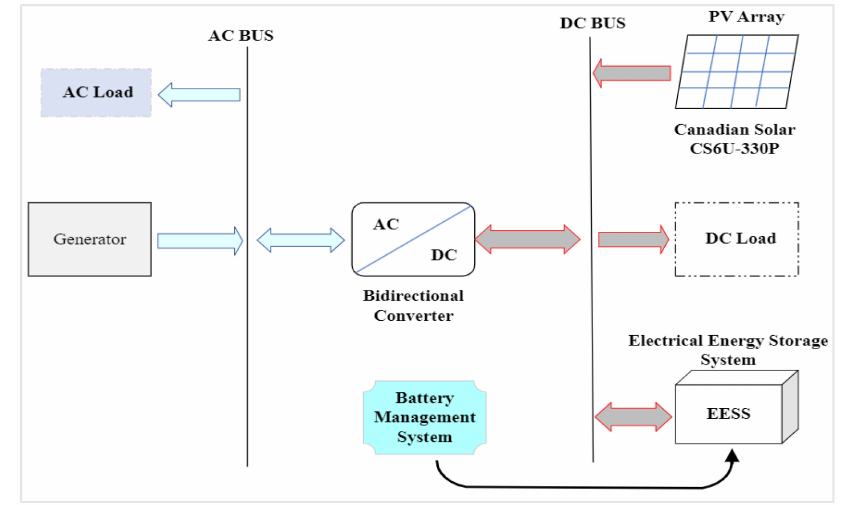
Figure 1. Grid-tied microgrid layout.